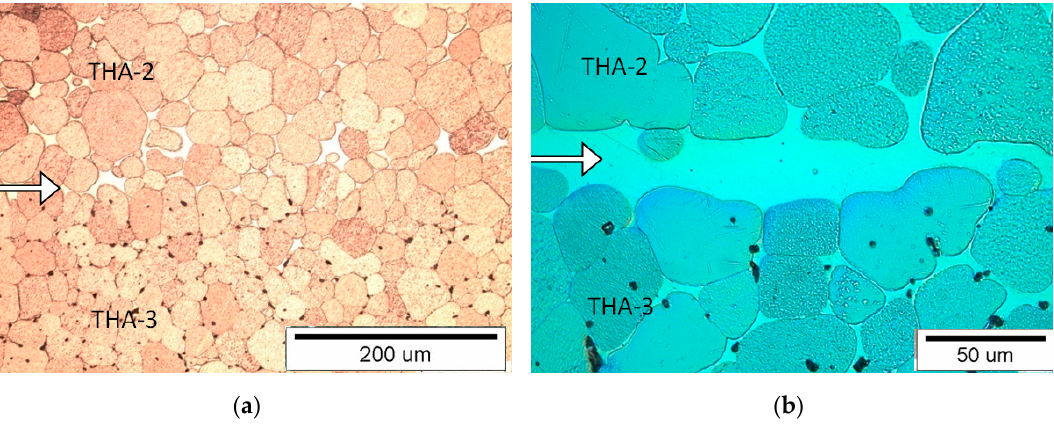
Figure 8. View of the microstructure of the THA-2 with THA-3 (with THA-2 on the top) at a magnification of 200× ( a ) and 500× ( b ), (the connection line (joint) is shown by the arrow).